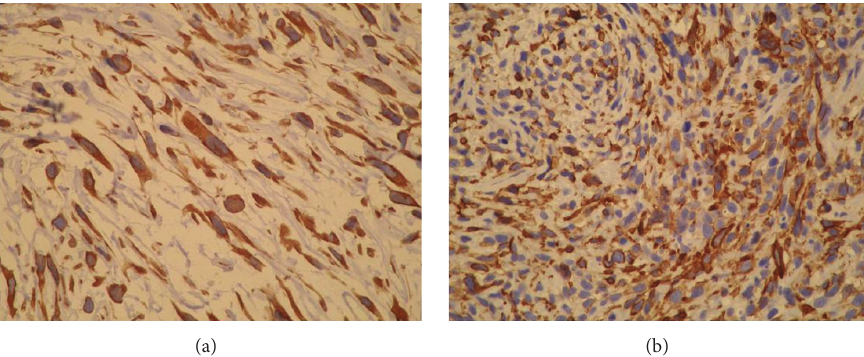
Figure 2: (a) and (b) Immunohistochemistry demonstrates that tumour cells express smooth muscle actin (a) and vimentin (b). Reproduced from